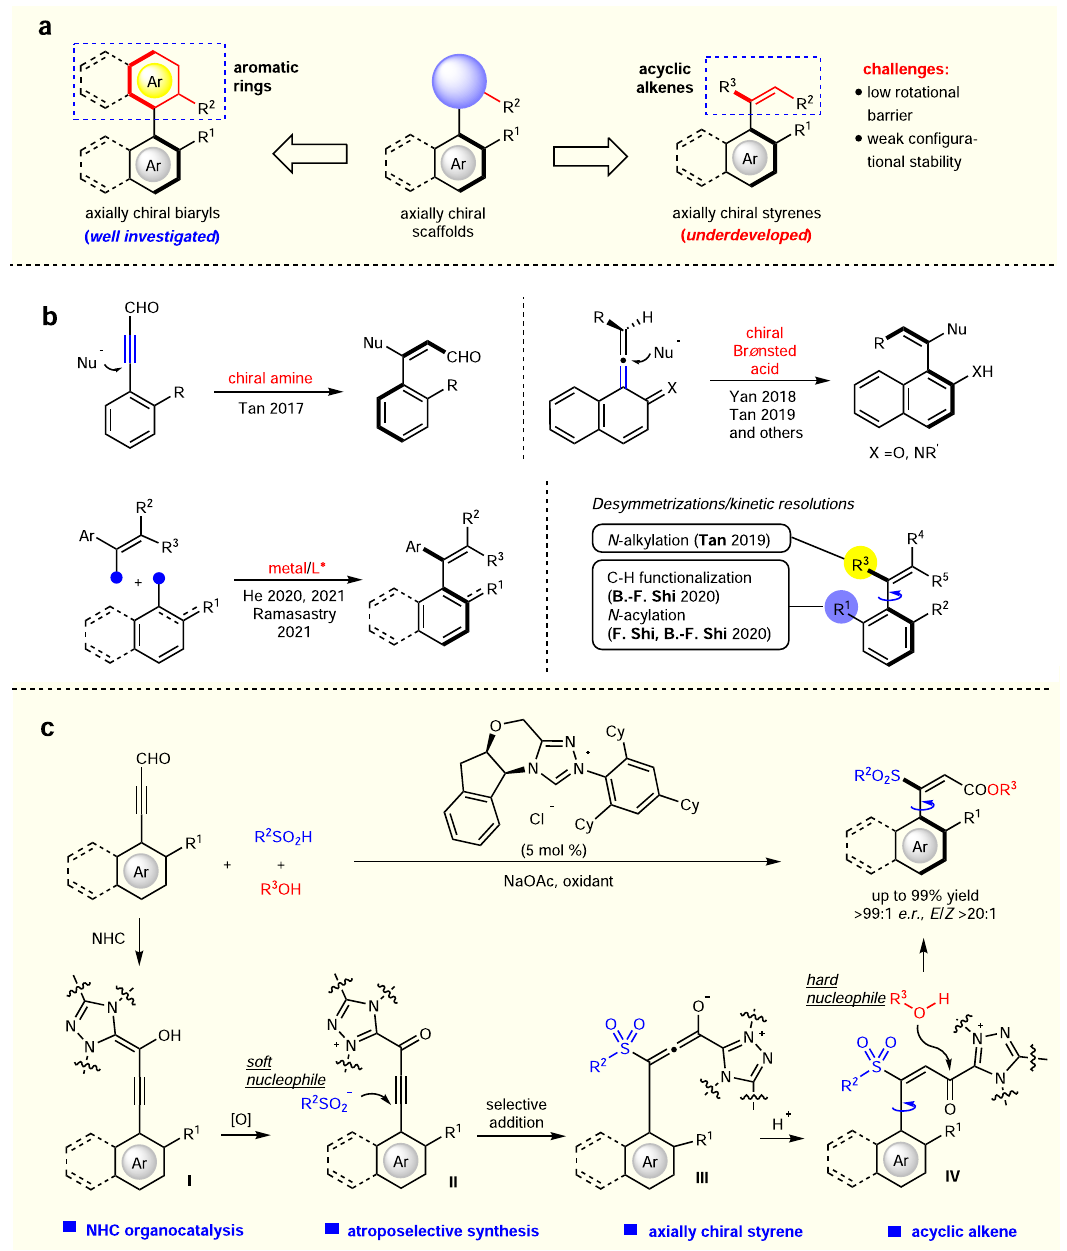
Fig. 1 Challenges and strategies to access axially chiral styrenes bearing acyclic alkenes. a Challenges in the synthesis of axially chiral styrenes bearing acyclic alkenes. b Previous methods for accessing axially chiral styrenes bearing acyclic alkenes. c Our Strategy: carbene-catalyzed chemo- and enantio- selective